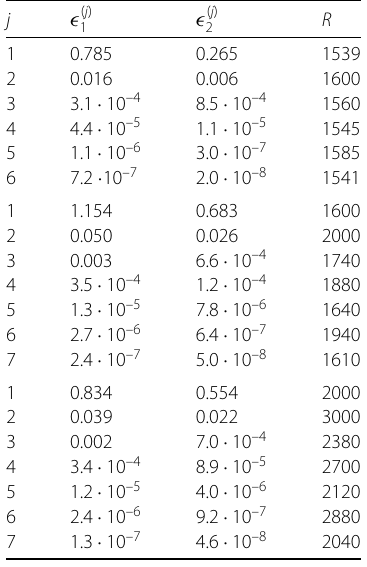
Table 6 (cid:15) ( j ) , (cid:15) ( j ) , j = 1, ... , N and the respective Rayleigh number R in which the maximum takes 1 2 place for different dimensions j of the reduced basis space. R is in the interval [1539;1600] for solutions S 5 in the first part of the table, R is in the interval [1600;2000] for solutions S 5 in the second part of the table and R is in the interval [2000;3000] for solutions S 5 in the last part of the table